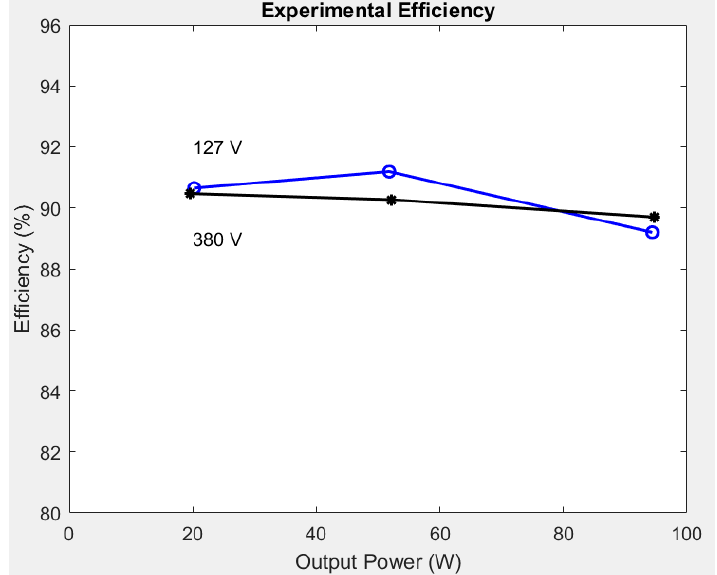
Figure 12. Experiment efficiencies of the dual-mode QRF converter.